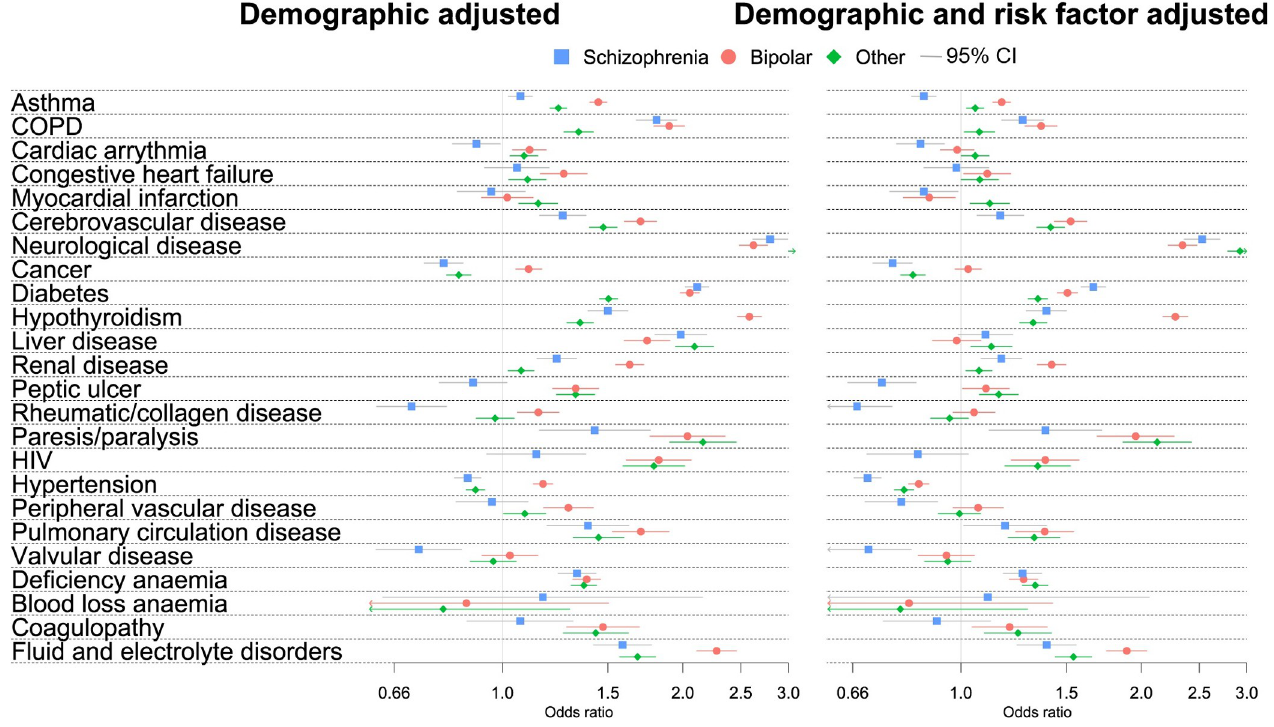
Fig 3. ORs of physical health conditions in those with SMI compared to the comparator population. CI, confidence interval; COPD, chronic obstructive pulmonary disease; HIV, human immunodeficiency virus; OR, odds ratio; SMI, severe mental